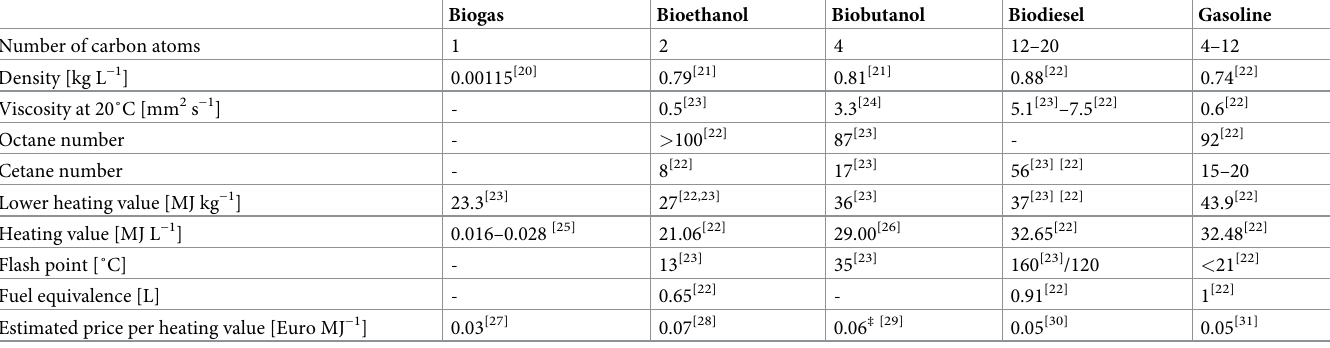
Table 1. Comparison of the physiochemical properties and average EU prices (2022/2023) of biofuels. Biogas